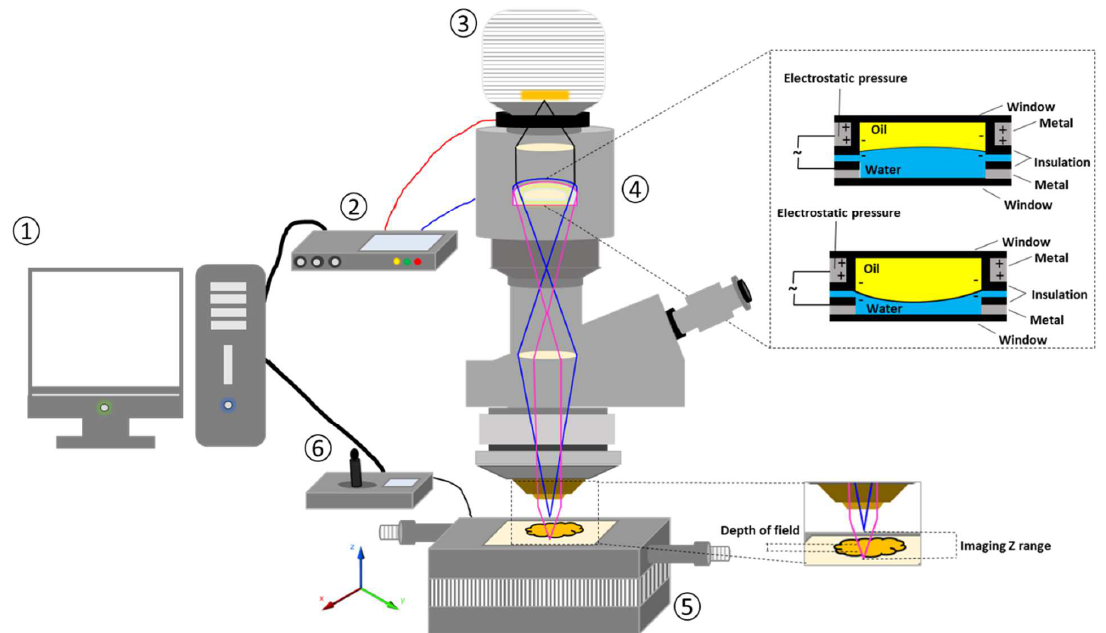
Figure 15. Schematic illustration of electrically tuneable lens (ETL)-based variable focus imaging system used for the surface texture analysis of the 3D-printed tablets: (1) computer; (2) ETL driver; (3) camera; (4) ETL; (5) automatic motorised vertical translation stage; and (6) stage controlling system [63] .